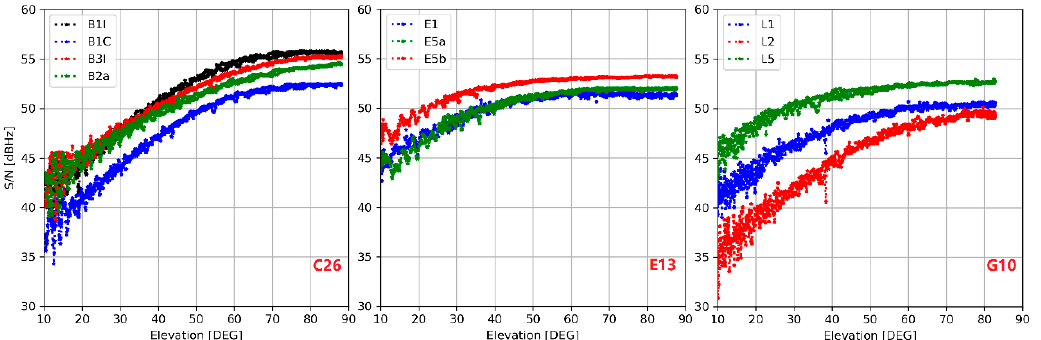
Figure 4. The signal to noise (S / N) performance of the observation data recorded by the HMNS station, where the S / N values of BD3 B1I / B1C / B2a / B3I signal are shown in the left, Galileo E1 / E5a / E5b and GPS L1 / L2 / L5 signal performance are shown in the middle and right panel,